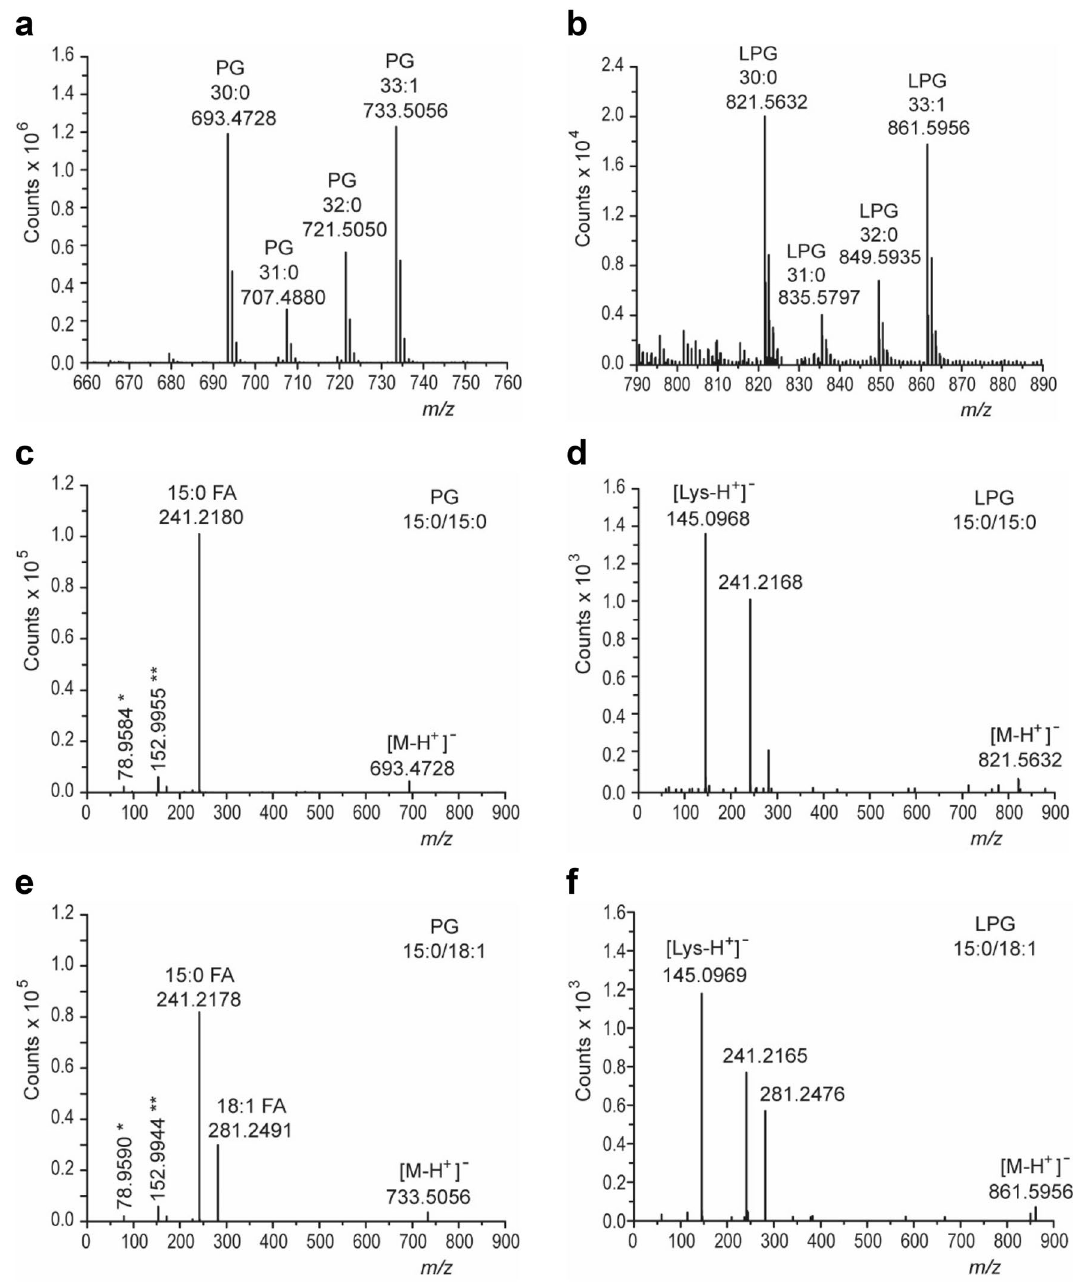
Figure 1. Analysis of polar lipids by quadrupole time-of-flight mass spectrometry. Phosphatidylglycerol (PG) and lysyl-phosphatidylglycerol (LPG) were detected in lipid extracts from cells of Listeria monocytogenes strain DSM 20600 T cells grown at 6 °C on tryptic soy agar-yeast extract medium supplemented with 0.1% (wt/ vol) polysorbate 80. The lipids were measured in the negative ion mode. Different molecular species of PG ( a ) and LPG ( b ) can be observed in the total ion spectra. Characteristic fragments in the MS/MS spectra of the respective lipids allow the detection of single fatty acids as indicated in the figure ( c – f ). Further fragments are characteristic for PG derived from the phosphite anion *[PO 3 ]¯ and the glycerolphosphate **[GroP]¯ head group. Fragmentation of LPG results in detecting a fragment ( m/z 145.09) derived from a deprotonated lysyl residue [Lys-H + ]¯ 51,52